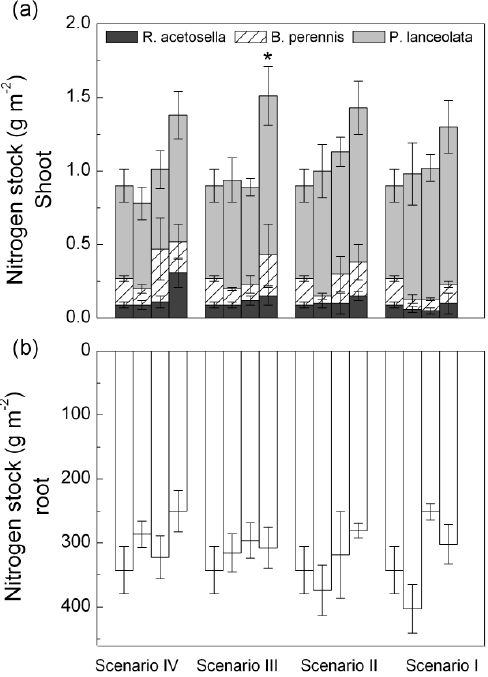
Fig. 7. Mean end-of-season (a) aboveground and (b) below- ground nitrogen stock, per scenario and treatment. C = control, D = drought, H = heat, DH = drought + heat. Asterisks above bars indicate significant differences between treatment and control on the community level ( P < 0 . 05). For differences on the species level, please refer to the text. Scenario IV = 42-day interval between subsequent events, scenario III = 25-day interval, scenario II = 14- day interval, scenario I = single event.